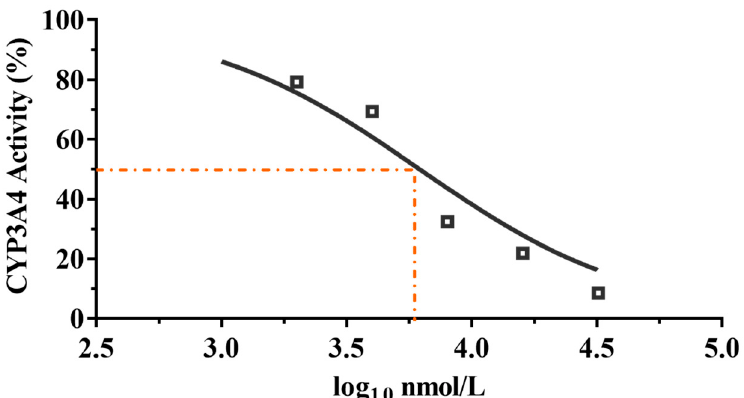
Figure 6. CYP3A4 inhibition by compound 9 with different concentrations.